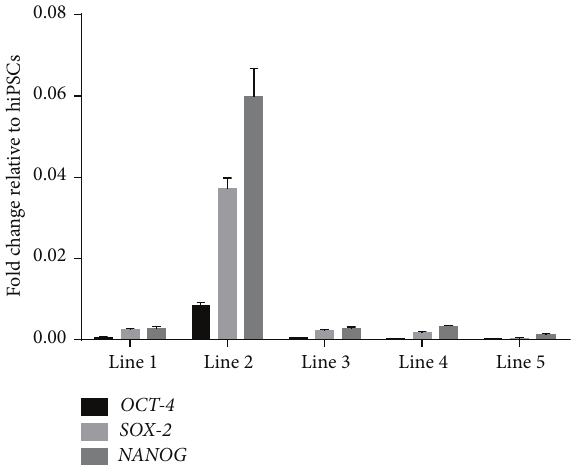
Figure 4: Neonatal sbMSCs express pluripotency-related genes Oct-4 , Nanog , and Sox-2 as determined by quantitative real-time PCR. Neonatal sbMSC line 2 had significantly upregulated expression of all these genes as compared to the other lines. Data were analyzed by two-way ANOVA and post hoc Tukey test and significant differences ( 𝑝 < 0.05 ).